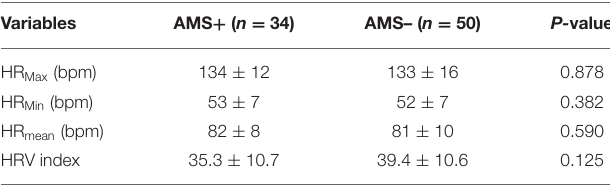
TABLE 2 | Comparison of ambulatory electrocardiogram at high altitude between two groups of volunteers.